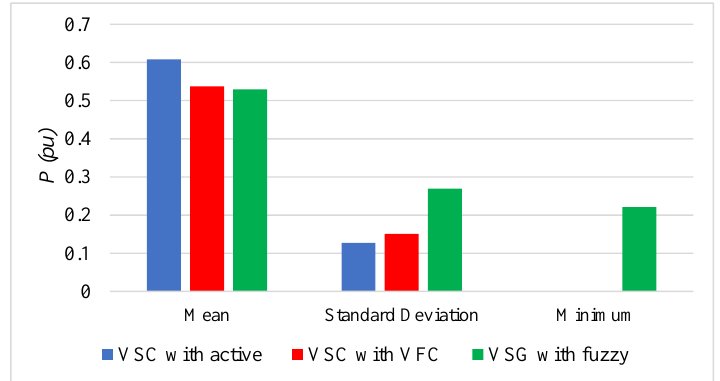
Figure 24. DER 1 output active power statistics for various